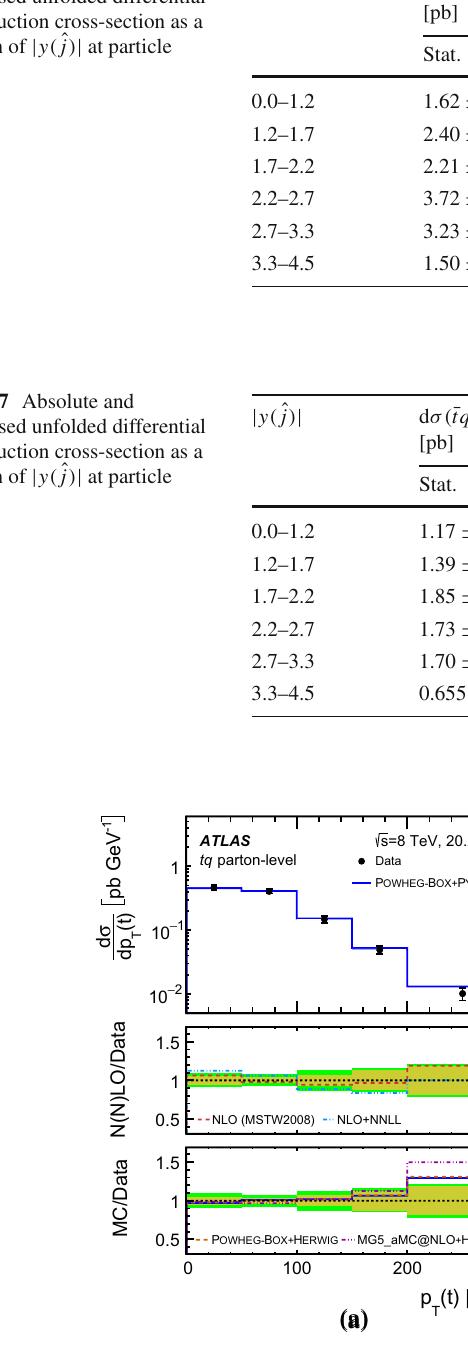
normalised unfolded differential tq production cross-section as a function of | y ( ˆ j ) | at particle